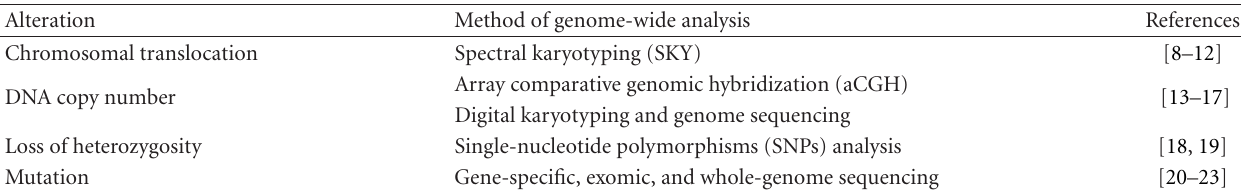
Table 1: Genome-wide methods for identifying genetic